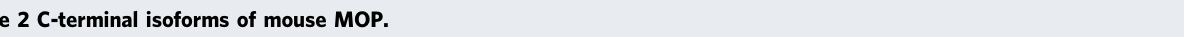
Table 2 C-terminal isoforms of mouse